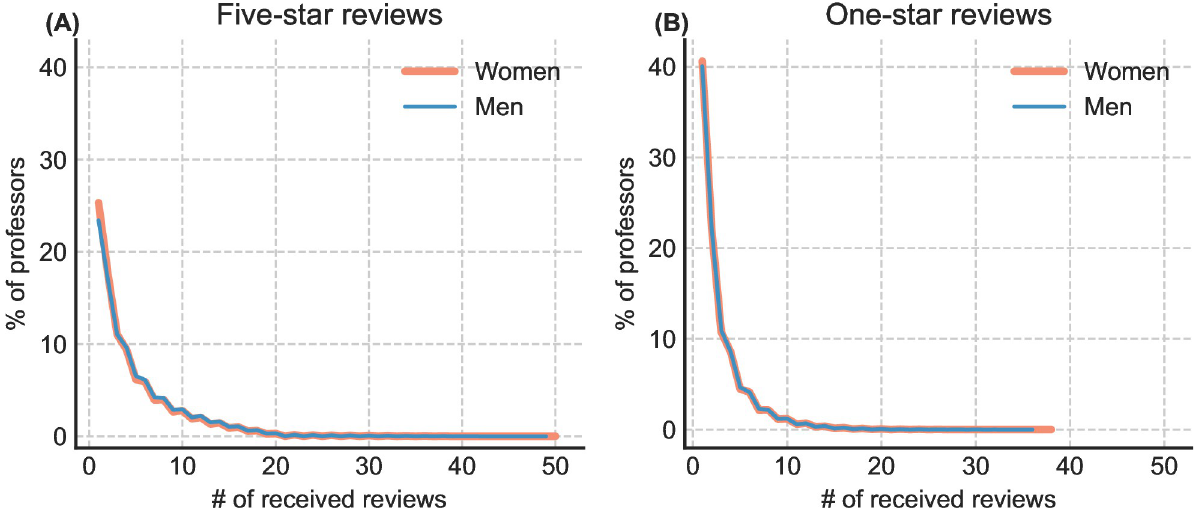
Fig 3. Professors’ percentage across the numbers of received reviews by professor gender and field. (A) In five-star reviews. (B) In one-star